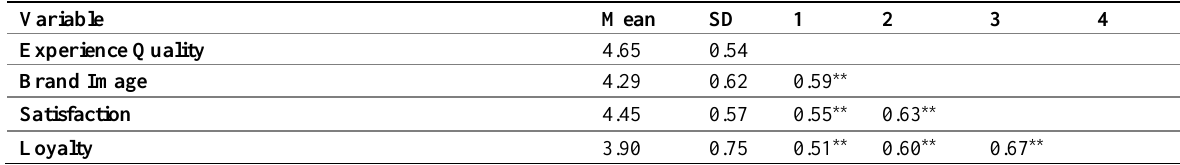
Table 3 : Descriptive Statistic and Correlation